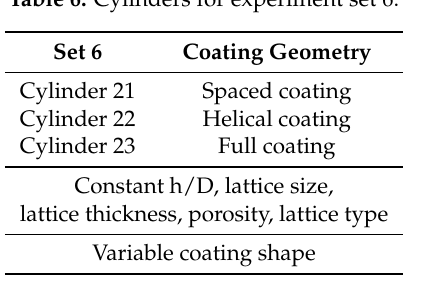
Table 6. Cylinders for experiment set